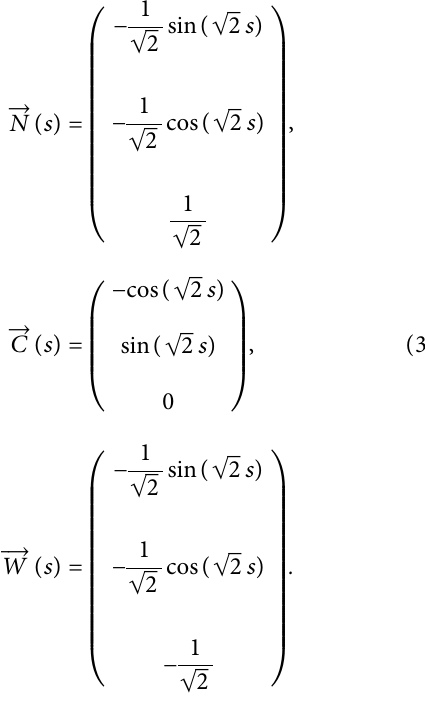
Figure 2: NW-smarandache ruled surface